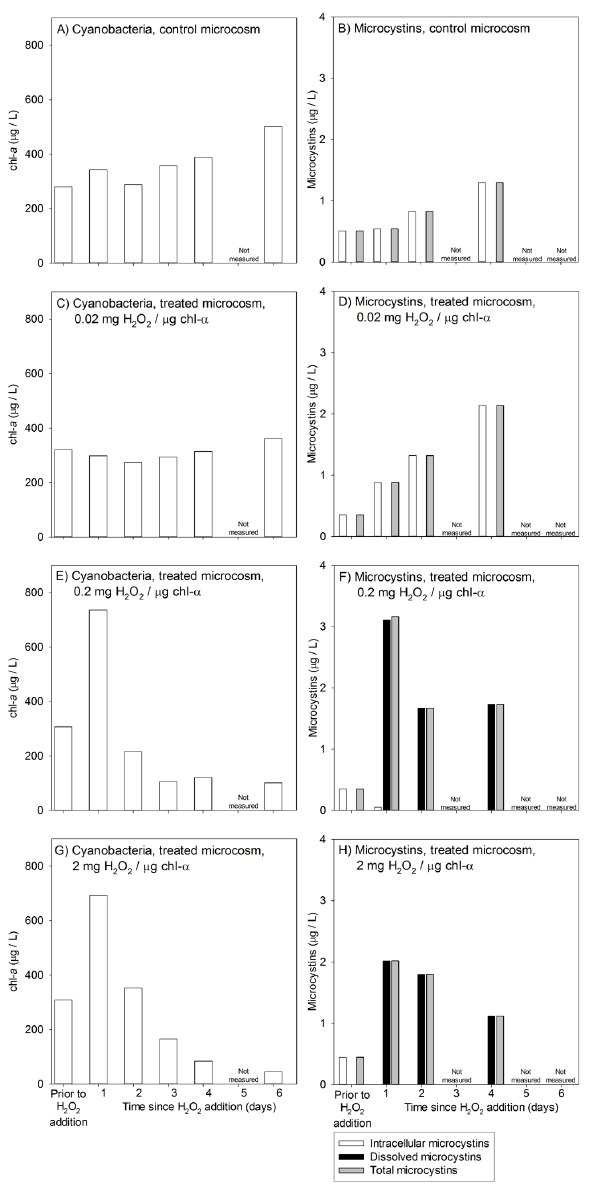
Fig. 2. Results from the second laboratory trial. (A) and (B) demon- strate cyanobacteria and microcystins dynamics in the control mi- crocosms, whilst (C) , (D) , (E) , (F) , (G) and (H) demonstrate their behaviour in the treated microcosms. All microcystins concentra- tions are expressed as microcystin-LR equivalents.